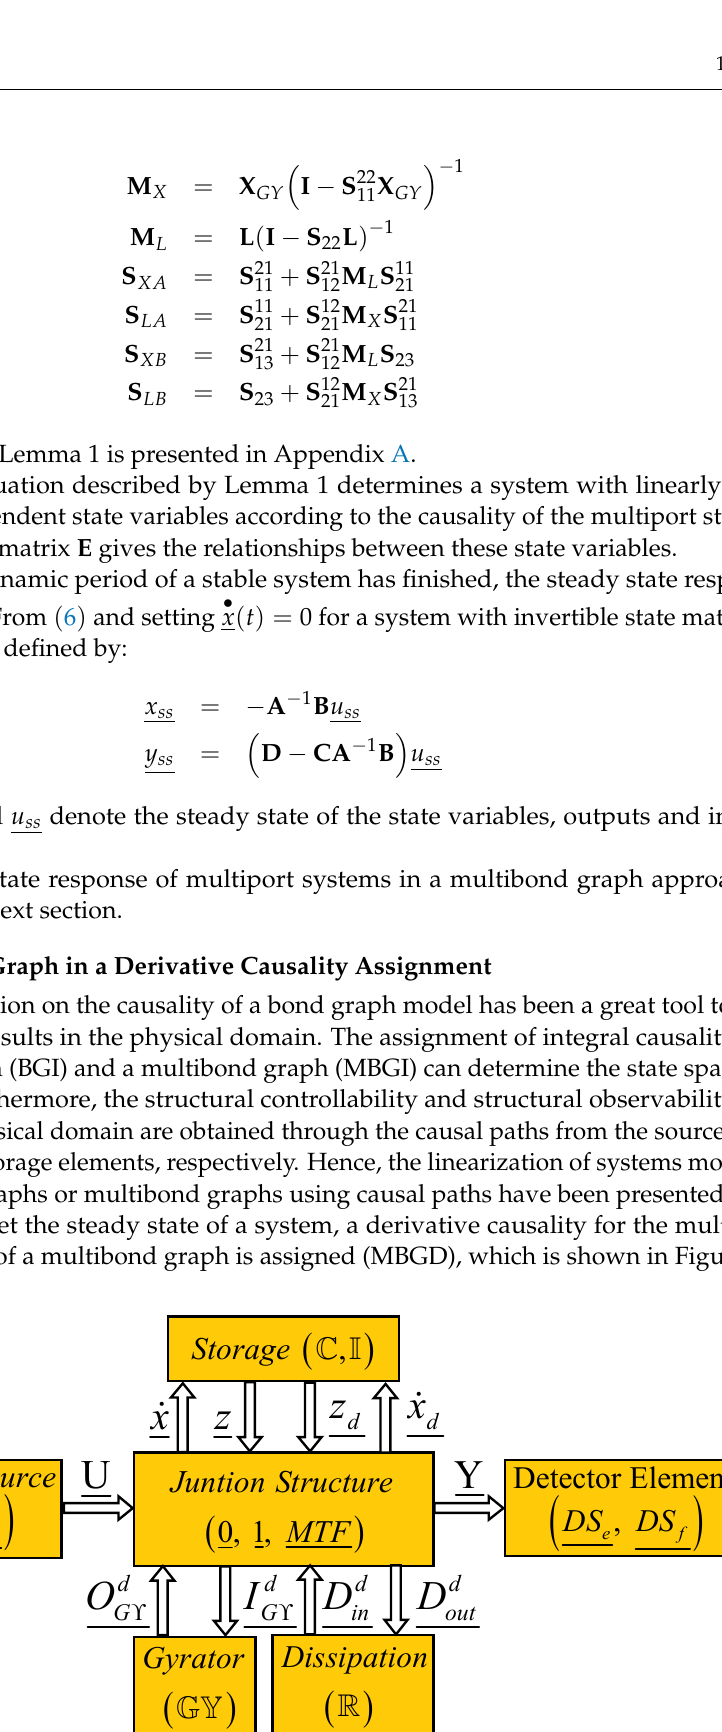
Fig. 7 . Junction structure